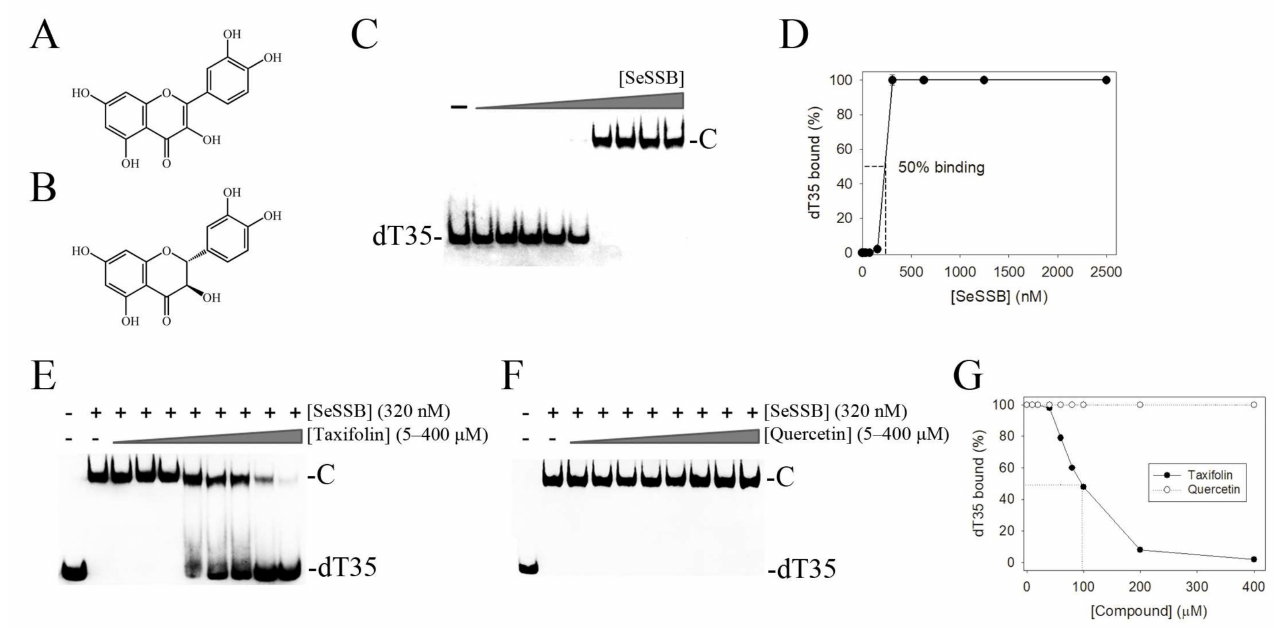
Figure 4. Inhibition of the ssDNA binding activity of the SeSSB by flavanonol taxifolin. ( A ) Molecular structure of the flavonol quercetin. ( B ) Molecular structure of the flavanonol taxifolin. ( C ) Binding of the SeSSB to ssDNA dT35. Purified SeSSB (0, 10, 19, 37, 77, 155, 310, 630, 1250, and 2500 nM) was incubated with biotin-labeled dT35 at 37 ◦ C for 60 min. A total of 310 nM SeSSB was sufficient to reach 100% binding of the dT35. ( D ) The titration curve for determining the binding constant. The dissociation constant of the SeSSB to bind ssDNA dT35 was calculated to be 230 ± 20 nM. ( E ) Inhibition of SeSSB by taxifolin. SeSSB (320 nM) was incubated with taxifolin (0, 5, 20, 40, 60, 80, 100, 200, and 400 µ M). ( F ) Inhibition test of SeSSB by quercetin. SeSSB (320 nM) was incubated with quercetin (5–400 µ M). These polyphenol compounds were dissolved in 10% dimethyl sulfoxide. ( G ) An IC 50 determination for SeSSB. Taxifolin could inhibit SeSSB binding to dT35, while